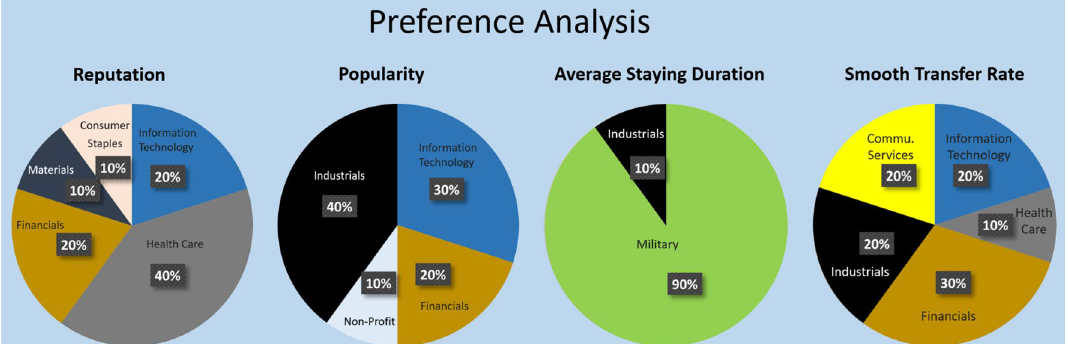
Figure 4. Business sectors of the top recommendations. This figure illustrates the portion of business sector of the top recommendations under different user preferences. The results are based on 200 career path simulations under different initial states. The weight for the preferred feature is set to be 0.7 while the rest being 0.1 each. We follow the Global Industry Classification Standard (GICS) to determine the business